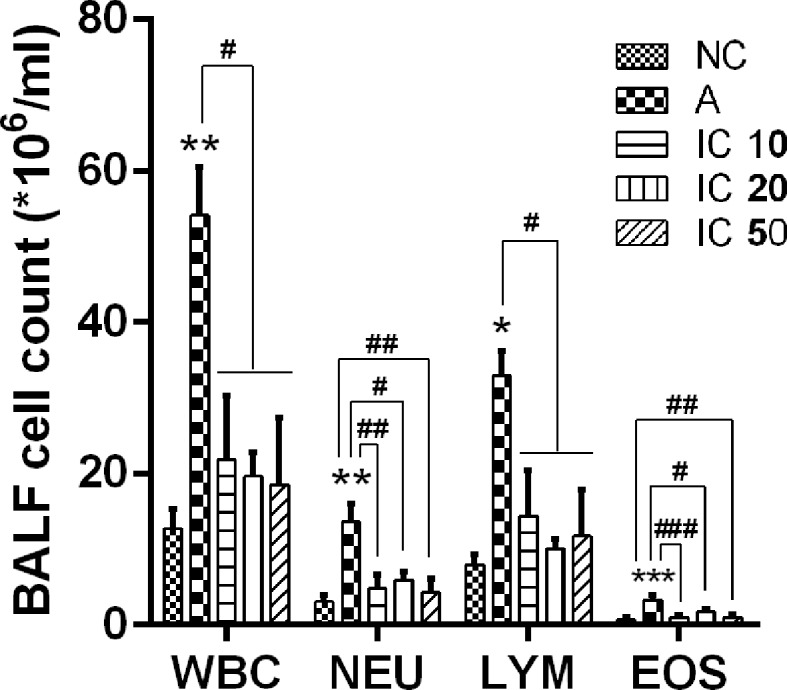
Icariin attenuated influx of inflammatory cells in the lung of asthmatic rats. Total white blood cells (WBC), neutrophils (NEU), lymphocytes (LYM), and eosinophils (EOS) were counted in BALF collected from the lung of rats in each group. *p < 0.05, **p < 0.01 and ***p < 0.001 vs. NC group; #
p < 0.05, ##
p < 0.01 and ###
p < 0.001 vs. A group.